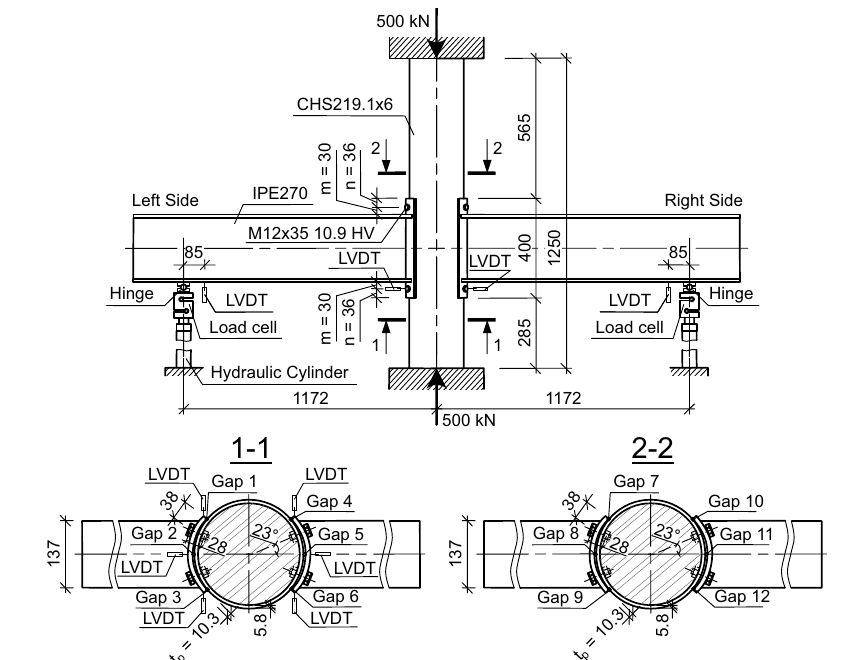
Figure 9. Testing rigs: a – bolt calibration setup; b – test